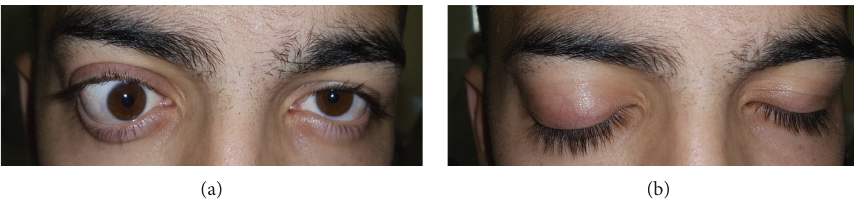
Figure 3: Preoperative images. (a) Observe the right exophthalmus, the downward and outward dislocation of the ocular bulb, which places the pupil’s axis toward the medial. Hypoglobus and anisocoria (right-sided mydriasis) are clearly visible symptoms. The movements of the ocular bulb are completely blocked cranially and laterally. (b) The previous images with closed eyes. On the right side, the upper eyelid closure is incomplete.